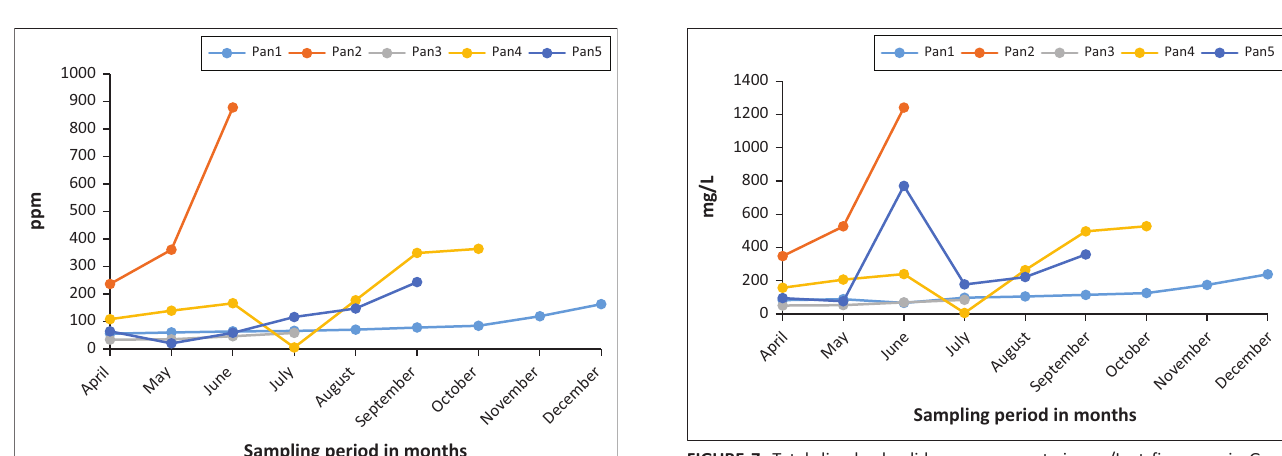
FIGURE 7: Total dissolved solids measurements in mg/L at five pans in Gras- Holpan between April and December 2019, where Pans 2 and 3 were in the savanna biome and Pans 1, 4 and 5 in the Nama-Karoo